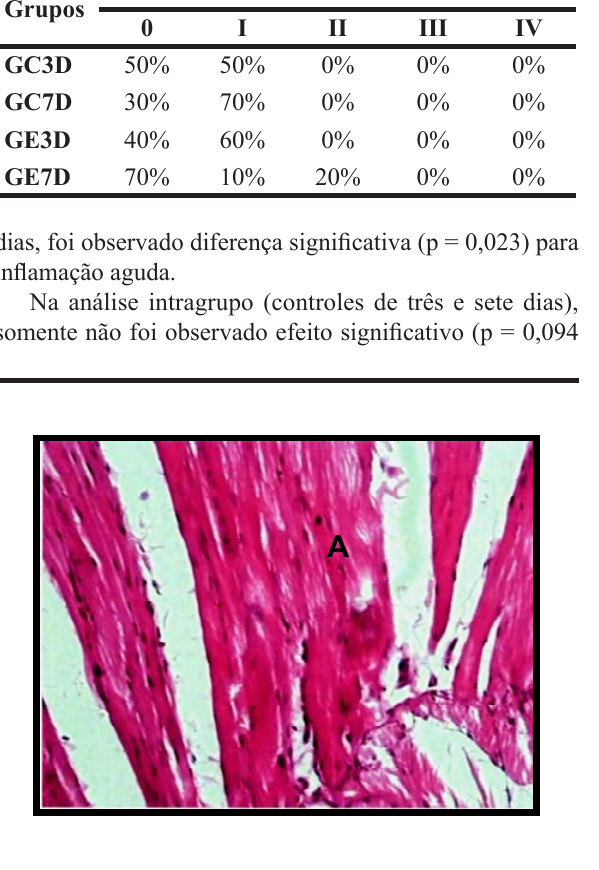
FIGURA 11 – Fotomicrografia de um animal do grupo GC7D.